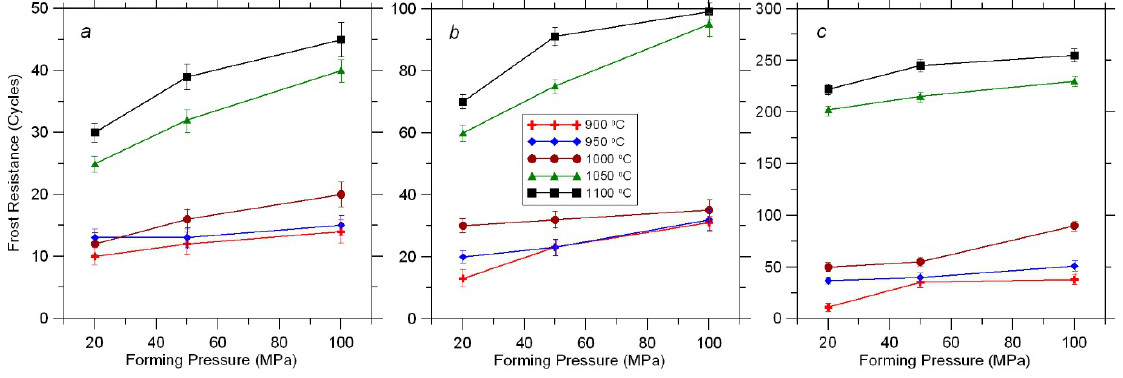
Figure 9. Variations in frost resistance versus forming pressure at different firing temperatures. ( a )—Non-processed samples. ( b )—Samples processed with water repellent. ( c )—Samples processed with granular molding powders.